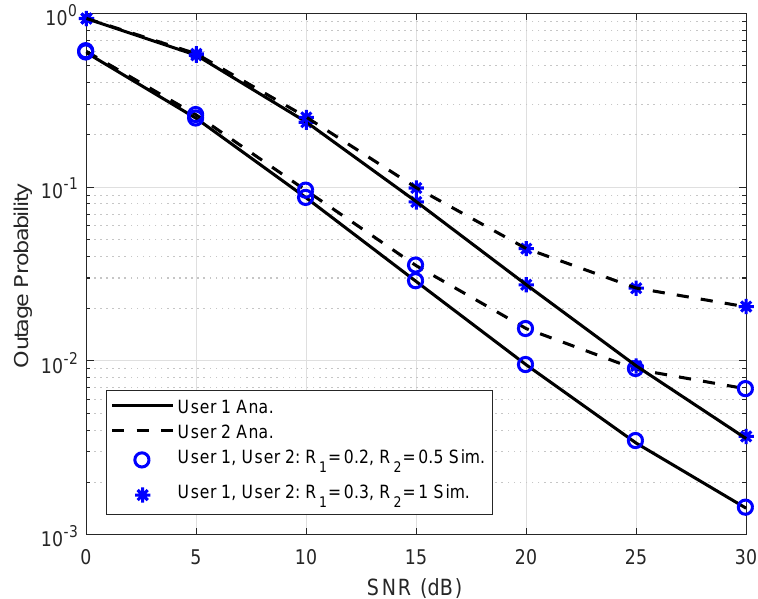
Figure 3. Outage probability of User 1 and User 2 versus